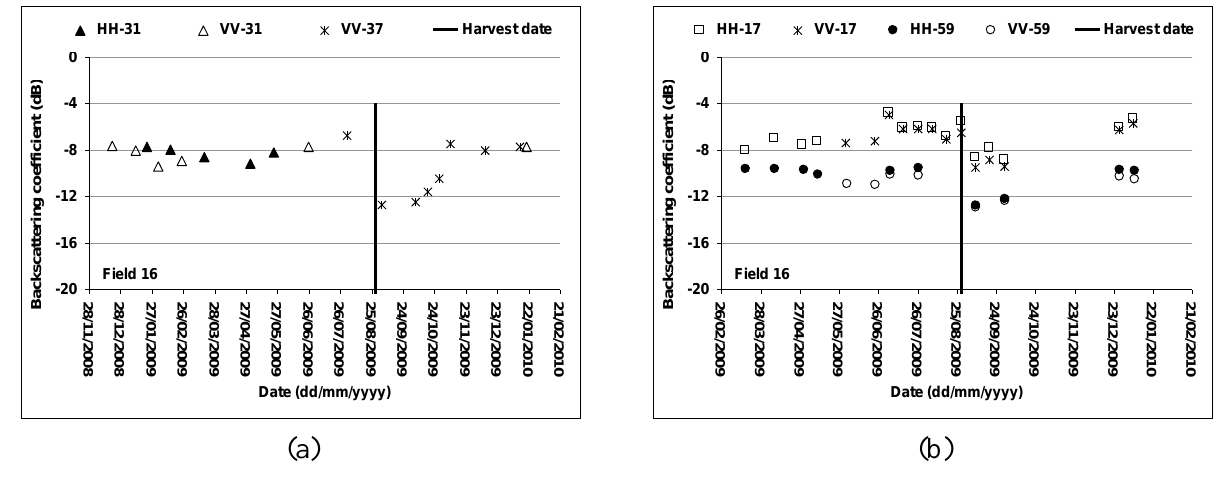
Figure 10. Temporal variation of TerraSAR signal for the reference sugarcane field 16. (a) 31 and 37°, (b) 17° and 59°. Field 16 was harvested on August 29,